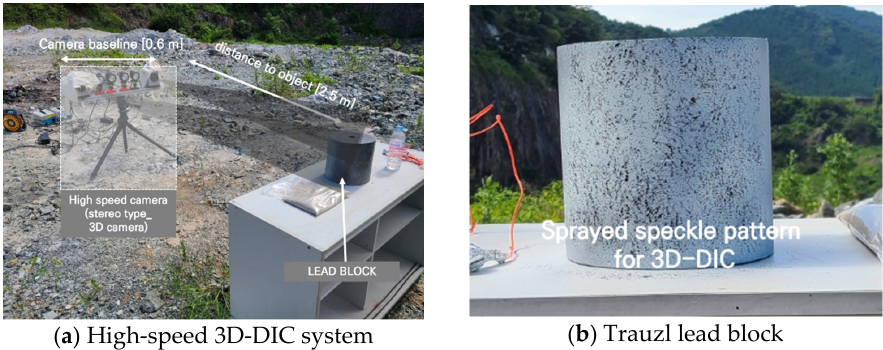
Figure 6. Installation of high ‐ speed 3D ‐ DIC system and Trauzl lead block . Table 2. Comparison of 2D/3D image correlation systems.